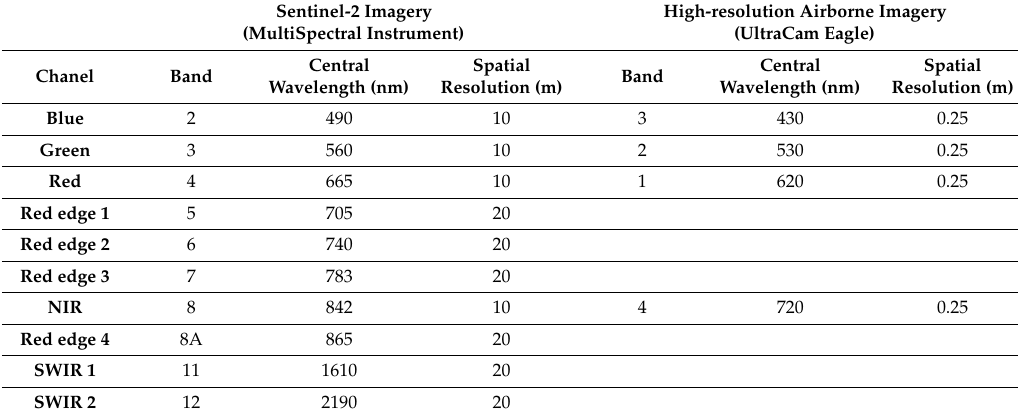
Figure 3. Chart describing the methodology of the experiment. Table 1. Comparison between the MultiSpectral Instrument bands of Sentinel-2 and Qioptic Vexcel HR Digaron bands of UltraCam